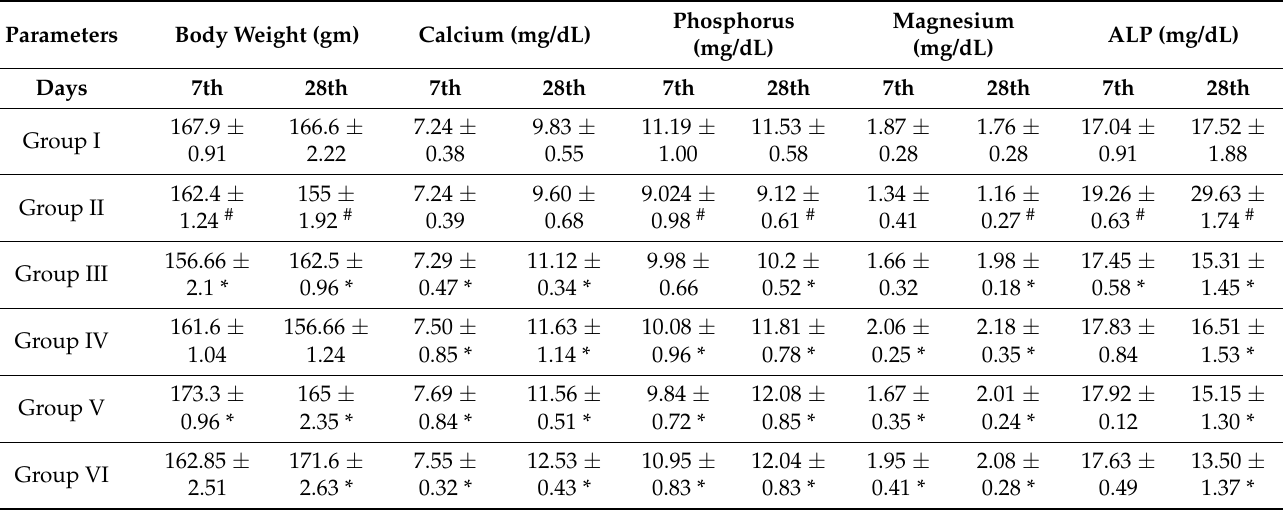
Table 1. Effect of therapeutic interventions on body weight, serum calcium, phosphorus, magnesium, and alkaline phosphatases (ALP)